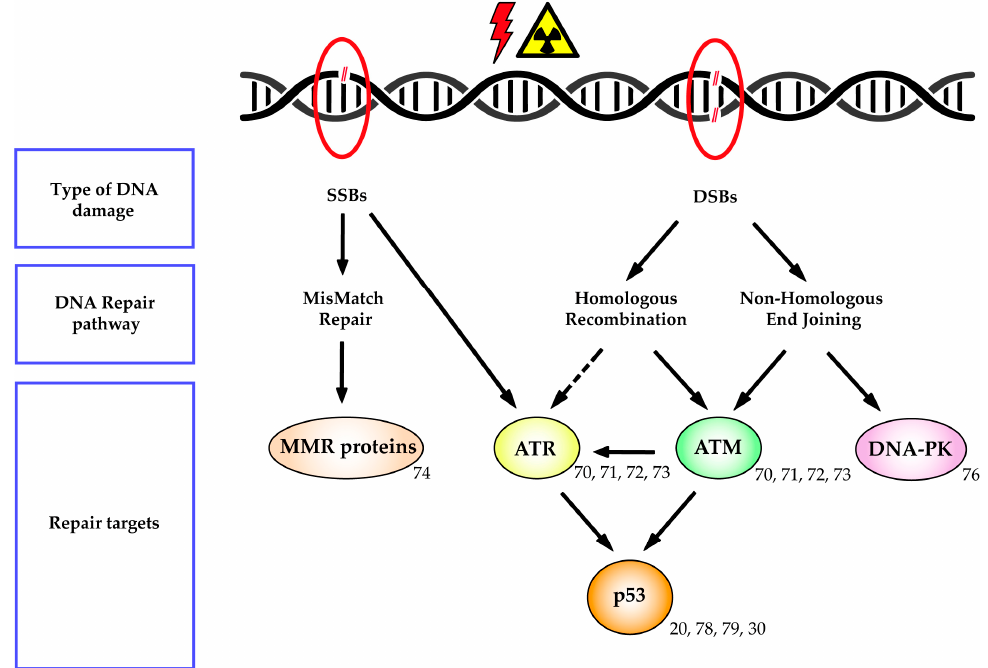
Figure 2. Activation of DNA repair mechanisms and their involvement in radiotherapy sensitivity in endometrial cancer. Scheme of the DNA repair pathways and targets activated by ionized radiation in EC. References of the studies performed in endometrial tissues or cells are indicated for each target.